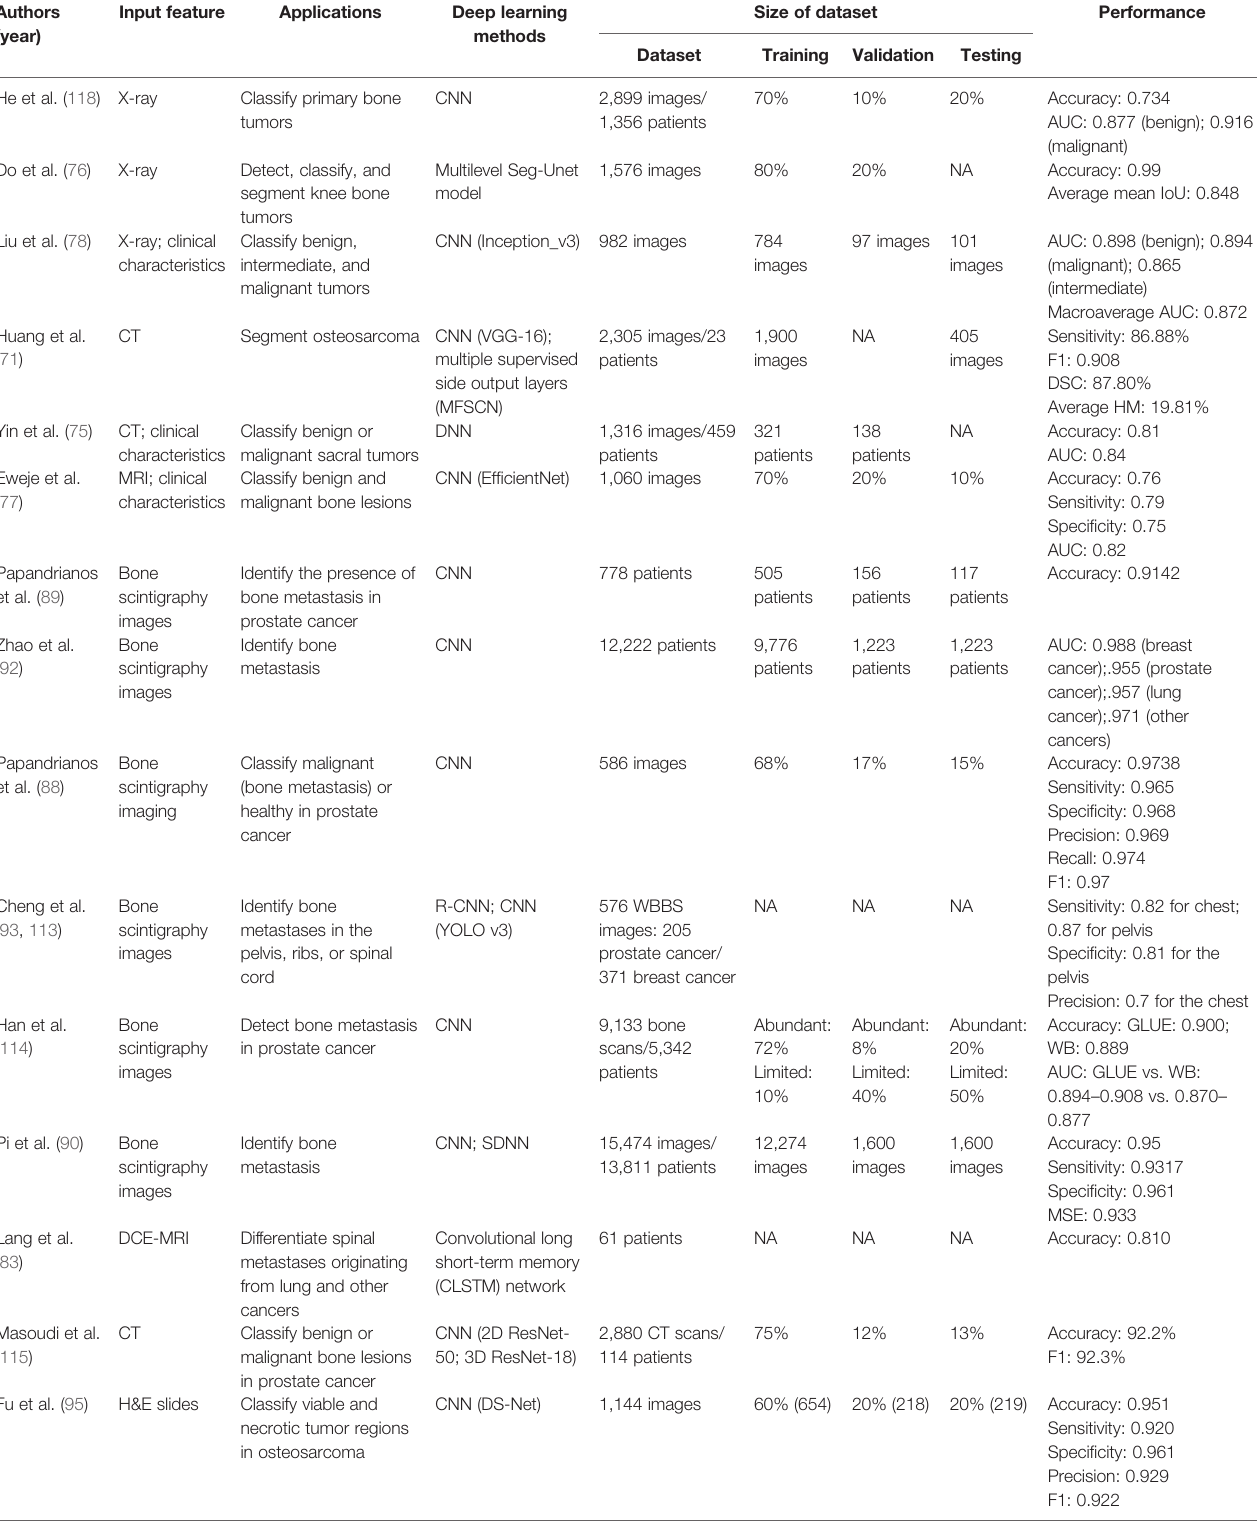
TABLE 1 | Summary of applications of deep learning-based arti fi cial intelligence in bone tumors. Authors